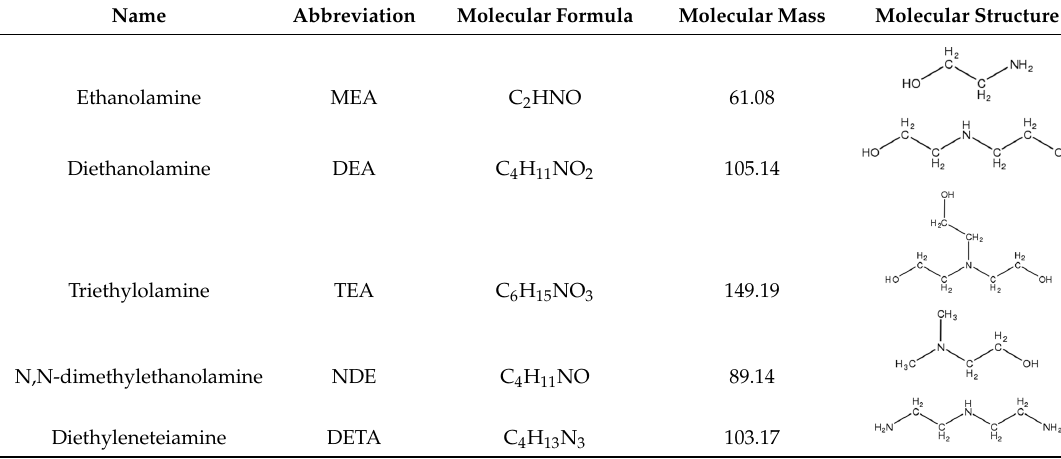
Table 1. The molecule structures of the compounds.